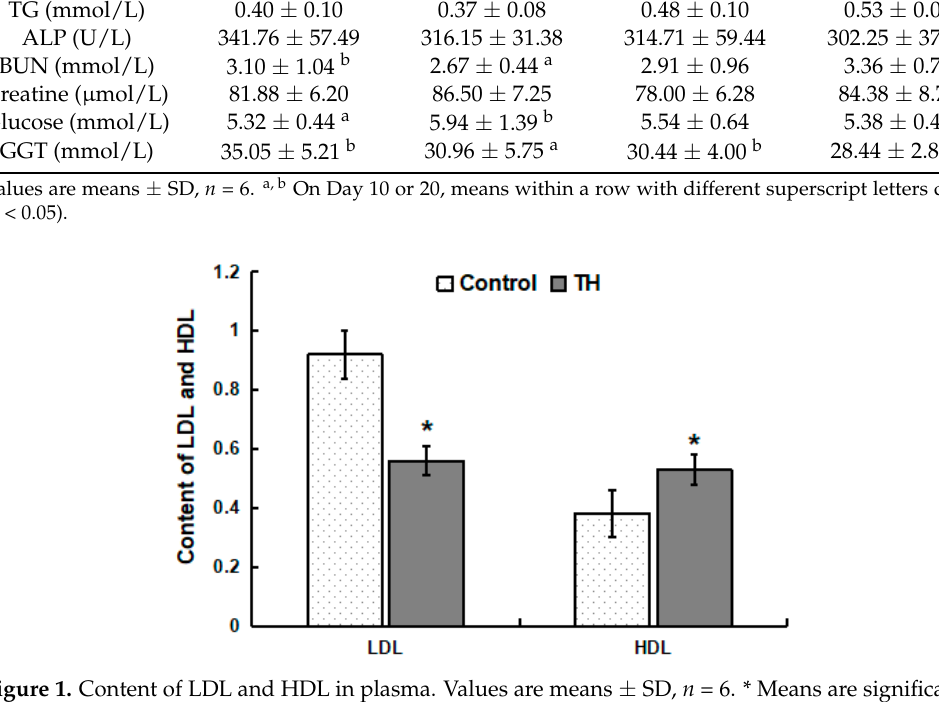
Table 2. Biochemical indices in the plasma of piglets receiving dietary supplementation with or without trihexanoin (TH).